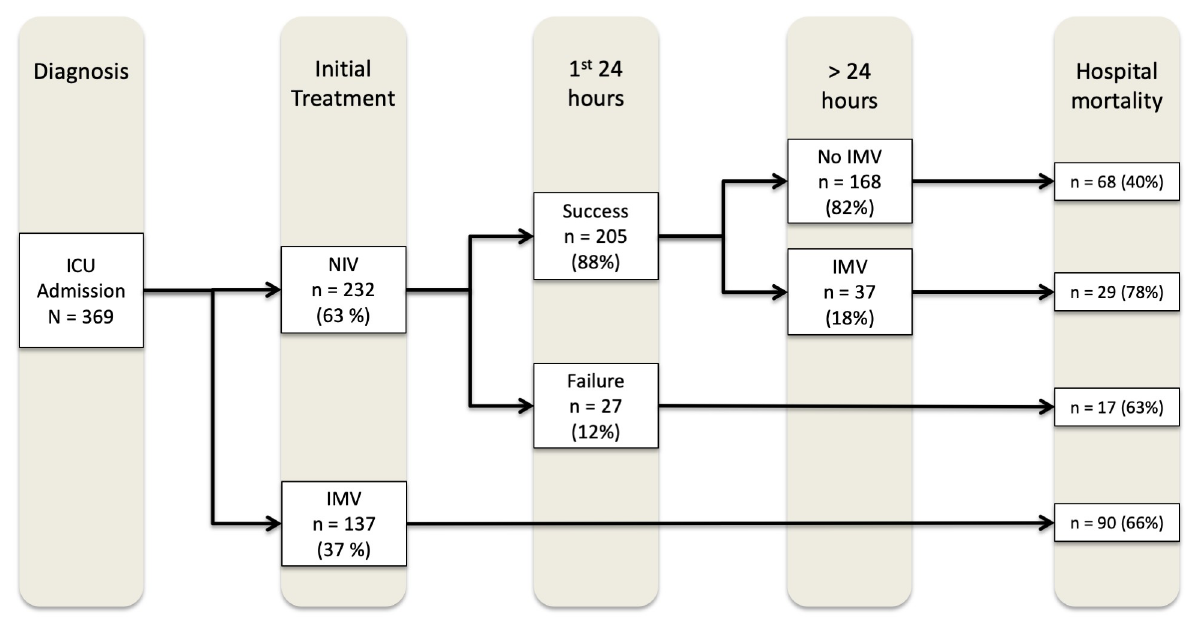
Fig 1. Flowchart of study participants from intensive care unit admission until the outcome (hospital death or discharge) according to the ventilation strategy. ICU: Intensive care unit; IMV: Invasive Mechanical ventilation; NIV: Noninvasive ventilation; Failure: need for IMV within 24 hours of ICU admission. Success: no need for IMV within 24 hours of ICU